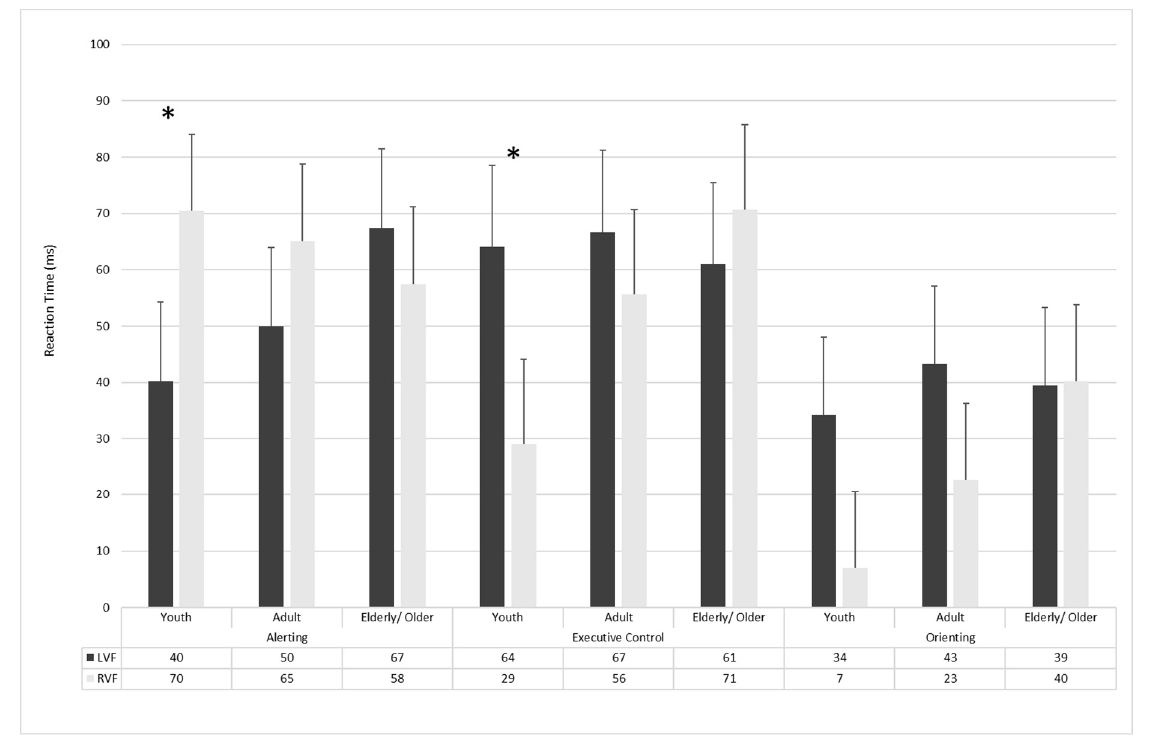
Figure 4. The alerting, conflict, and orienting effects as a function of visual field and age. * : p < 0.05